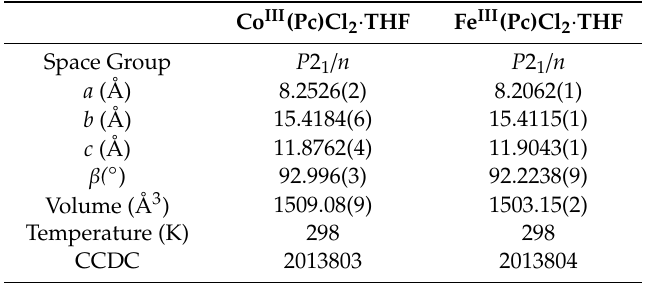
Table 1. Crystal data of Co III (Pc)Cl 2 · THF and Fe III (Pc)Cl 2 ·